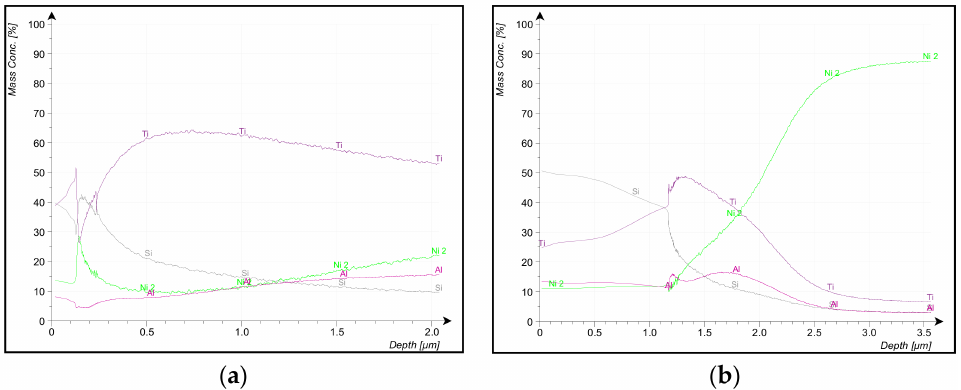
Figure 11. Percentage of mass concentration vs. depth of AlTiSiN coating in ( a ) outer face and ( b ) inner